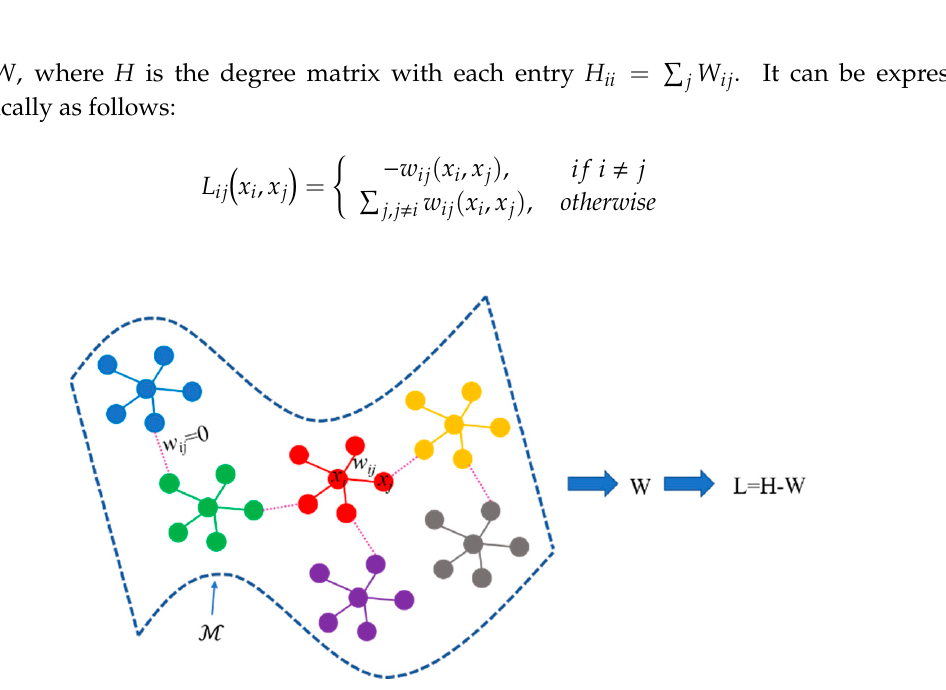
Figure 2. Graph construction.